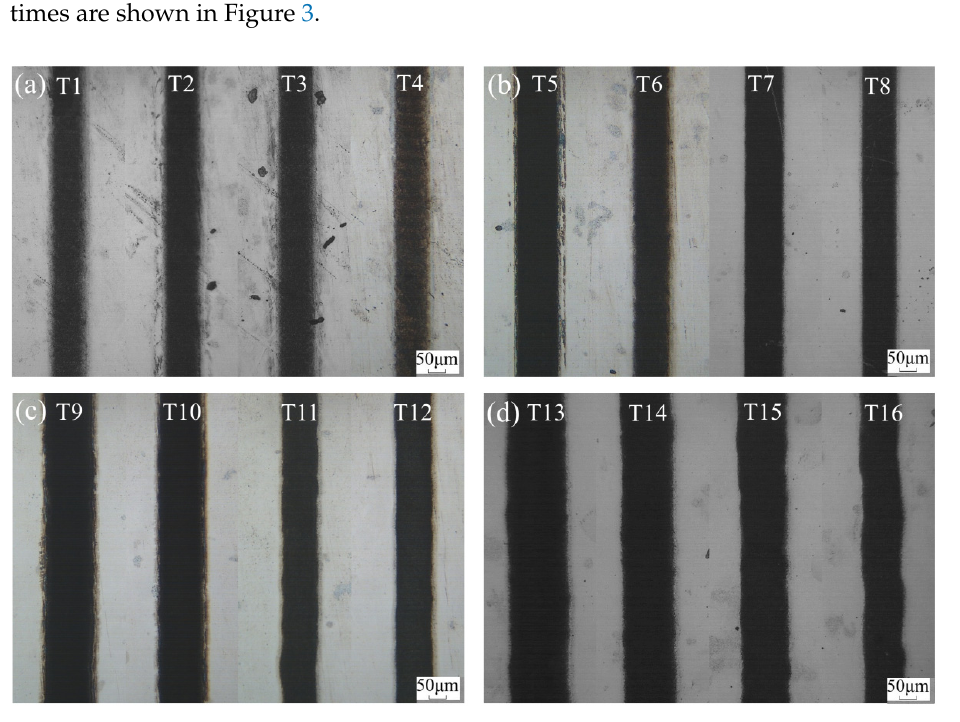
Figure 3. Optical micrographs of the groove textures ( a ) T1 ‒ T4, ( b ) T5 ‒ T8, ( c ) T9–T12, ( d ) T13 ‒